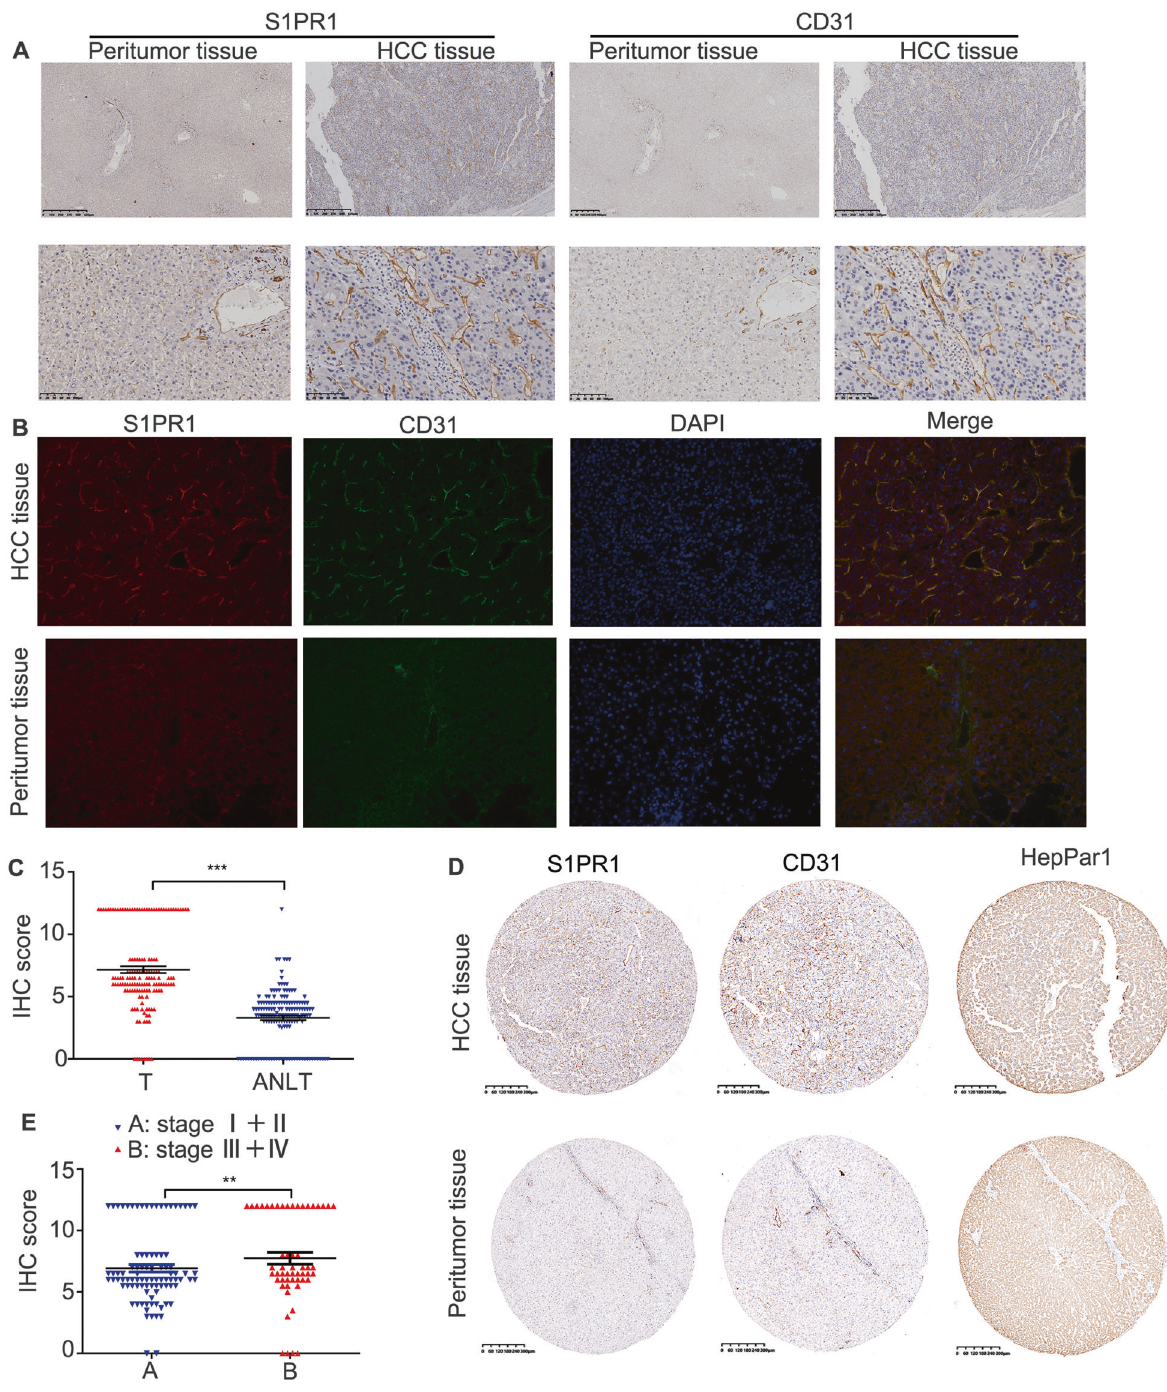
Fig. 1 Upregulation of S1PR1 in the vascular ECs of HCC and its association with advanced HCC stage. A Serial sections of paraf fi n- embedded HCC and peritumour tissues were stained with an anti-S1PR1 or an anti-CD31 antibody. Scale bar: 625 μ m (top), 100 μ m (bottom). B Expression of CD31 (green) or S1PR1 (red) in the frozen tissue sections of HCC tissues and peritumour tissues was determined by IF. DAPI staining is indicated in blue. Scale bar: 150 μ m. C Quantitative analysis of S1PR1 protein levels in 150 paired samples of HCC tissues (T) and paired adjacent nontumorous liver tissues (ANLT) according to IHC scores, and the signi fi cant difference was analysed by paired sample Student ’ s t test (*** P < 0.01). D CD31 (endothelial cell marker) and Hepar-1 (liver cell/liver cancer cell marker) were used to distinguish the expression pattern between endothelial and tumour cells in HCC tissues by IHC. Scale bar: 625 μ m. E The IHC score was used to analyse the expression of S1PR1 in vascular ECs in different stages of HCC by Student ’ s t test (** P < 0.05).